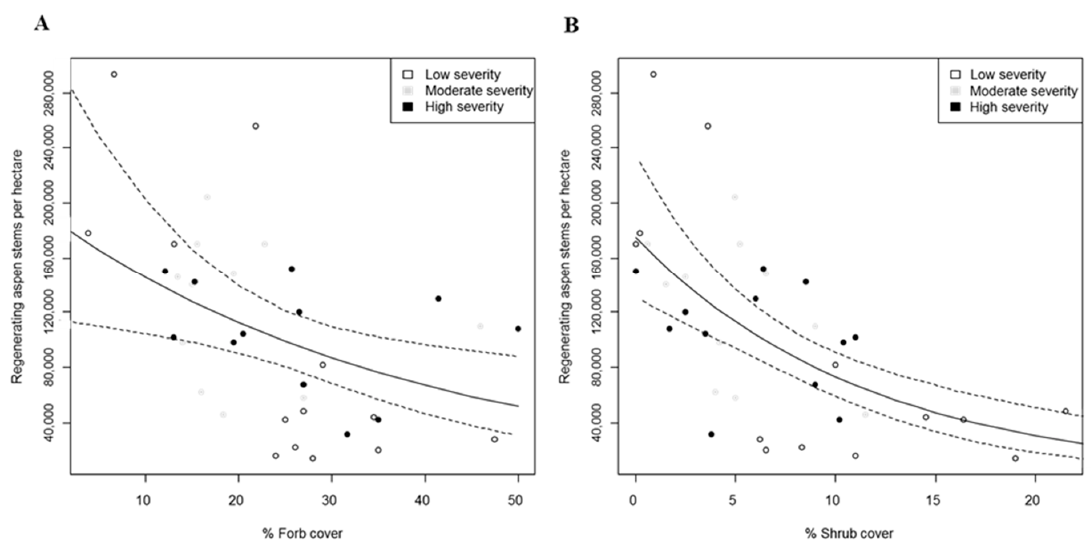
Figure 6. ( A ) Observed amount of aspen regeneration over a range of forb cover (%) with a fitted negative binomial GLM curve (solid line) and 95% confidence bands (dotted lines). ( B ) Observed amount of aspen regeneration over a range of shrub cover (%) with a fitted negative binomial curve (solid line) and 95% confidence bands (dotted lines). Regeneration reported in stems per hectare.